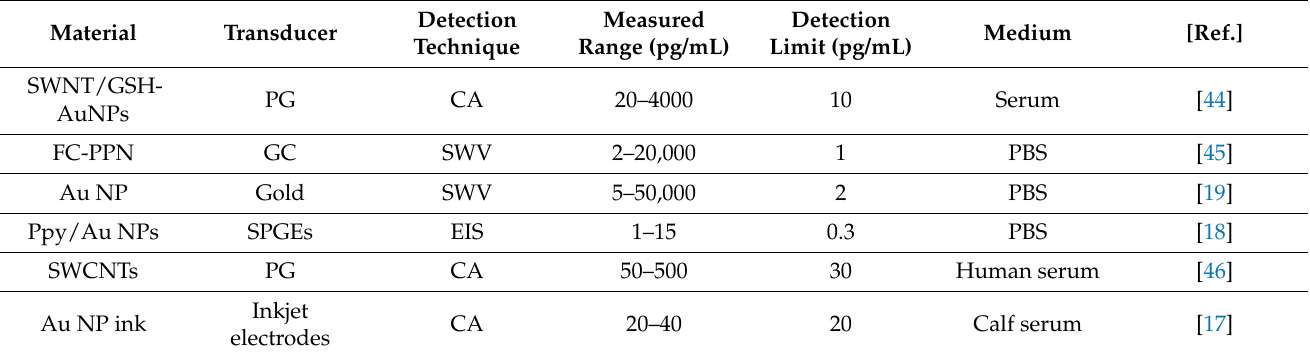
Table 1. Comparison of different electrochemical biosensors for IL-6 detection